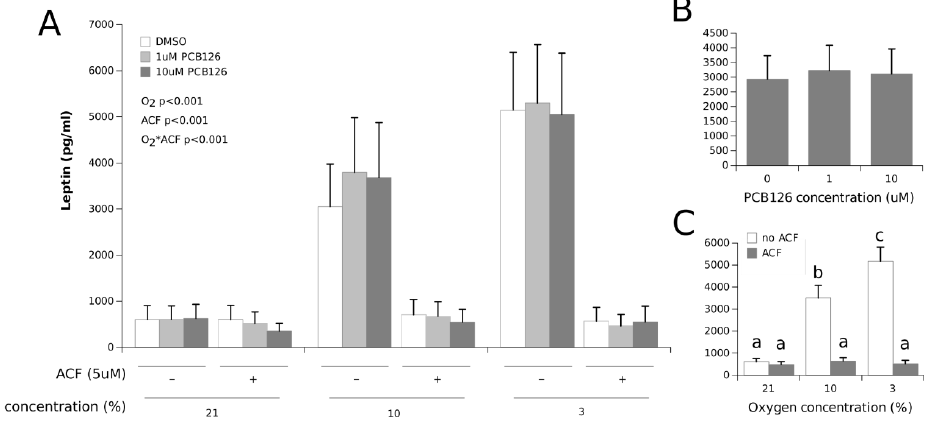
Figure 3. Effect of PCB126 and hypoxia on the media leptin concentration in human adipocytes. Adipocytes were treated with DMSO (vector) or 1 and 10 µM PCB126 for 24 h, and then subjected to 21, 10 or 3% O 2 for another 24 h. Acriflavine (ACF) 5 µM was used as an HIF 1α -inhibitor. Panel ( A ) illustrates the whole model. Markers of statistical difference for individual bars were omitted due to the complexity of the model. Panel ( B ) summarizes the main effect of PCB126 on the media leptin concentrations. Panel ( C ) summarizes the effects of hypoxia and ACF treatment on the media leptin concentrations. Bars not sharing a common letter are statistically different at p < 0.05. Each bar represents the mean ± SEM of three separate experiments for each treatment group.